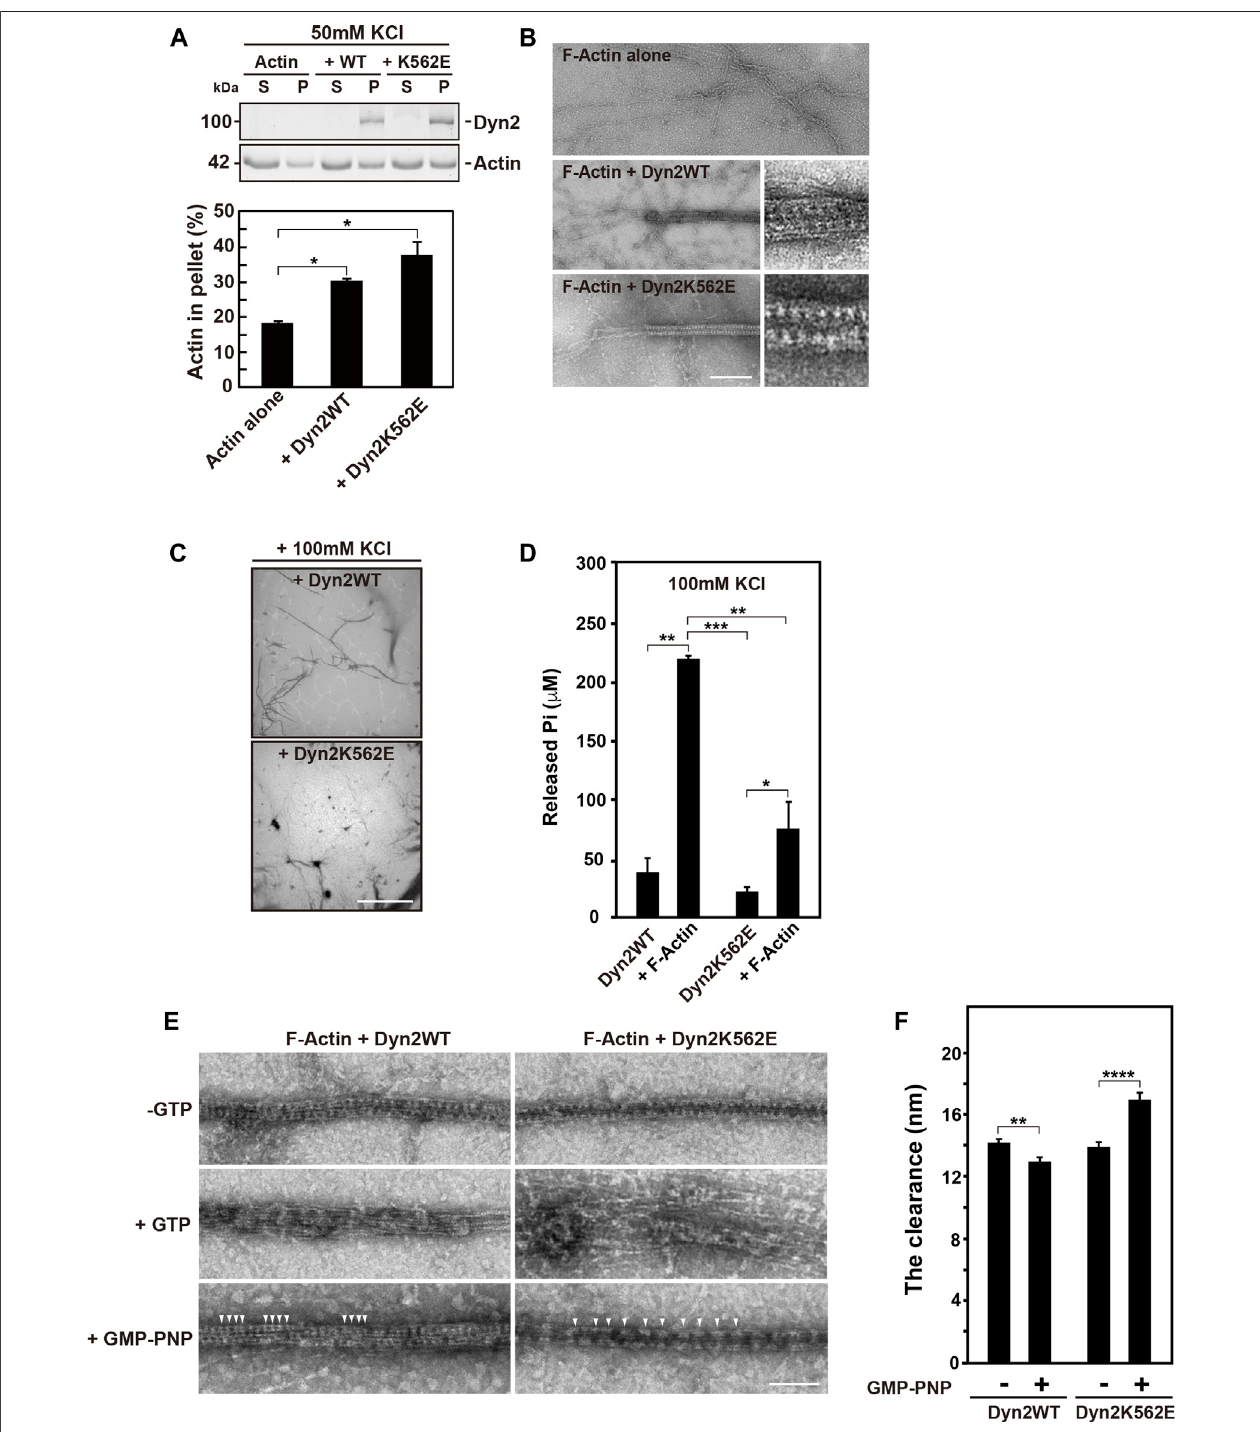
FIGURE 4 | In vitro actin bundle formation by dynamin 2 (Dyn2)-WT or K562E. (A) Low-speed sedimentation assay for dynamin 2-WT- or K562E-induced actin bundle formation in low ionic strength buffer. The top panel shows actin in thepellet (P) or supernatant (S)fraction in the presence or absence of dynamin. Quanti fi cation of actin in the low-speed pellet in actin only, dynamin 2-WT, and K562E samples by densitometry (bottom panel). Data are means ± S.E.M. of three independent experiments. (*; p < 0.05). (B) Transmission electron micrographs of negatively-stained actin bundles formed by dynamin 2-WT (middle) or K562E (bottom). Scale bar: 200 nm, 50 nm in enlarged images. (C) Low magni fi cation electron micrographs of negatively-stained actin bundles show a decrease in actin bundle formation by dynamin 2-K562E in the high ionic strength buffer. Scale bar: 8.5 μ m. (D) Actin fi laments (F-Actin) increases Pi release by dynamin 2-WT or K562E. Data are means